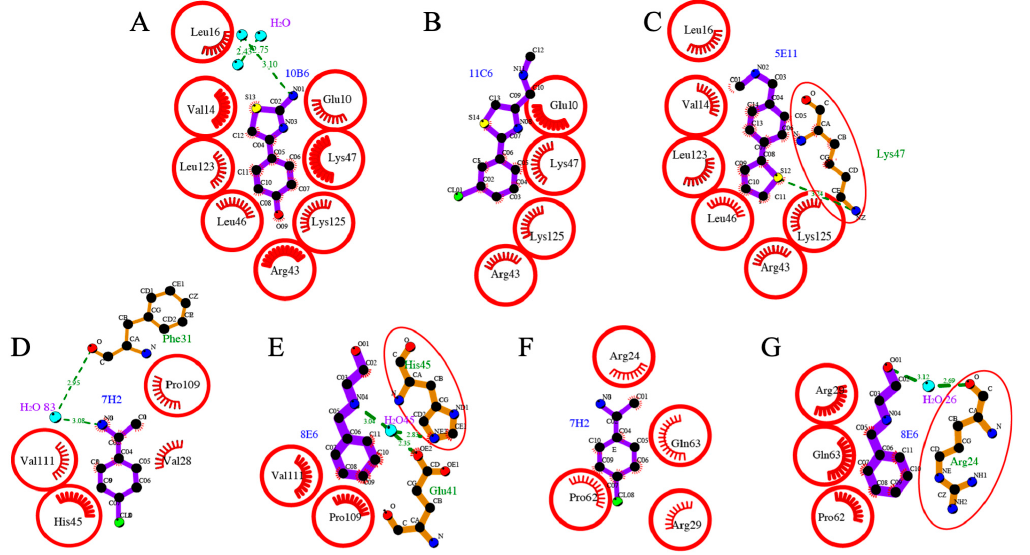
Figure 4. Molecular interactions of fragment hits binding to SARS-CoV-2 nsp1 10-126 . Hydrophobic interactions are displayed by red half-moons and identical residues are shown with a red circle. Hydrogen-bond interactions are shown with a dotted green line. Three fragment hits ( A ) 10B6 , ( B ) 11C6 and ( C ) 5E11 interacting with the residues of SARS-CoV-2 nsp1 10-126 in binding pocket I. The binding conformation is switched in 5E11 , in which the 5- and 6-membered ring system exchange their positions compared to 10B6 and 11C6 . Fragment hits 7H2 and 8E6 interacting with the residues located in binding site II. 7H2 binding to ( D ) SARS-CoV-2 nsp1 10-126 and ( F ) a symmetry mate. 8E6 interacting with ( E ) SARS-CoV-2 nsp1 10-126 and ( G ) a symmetry-related molecule. The substituent of 8E6 is not visible in the electron